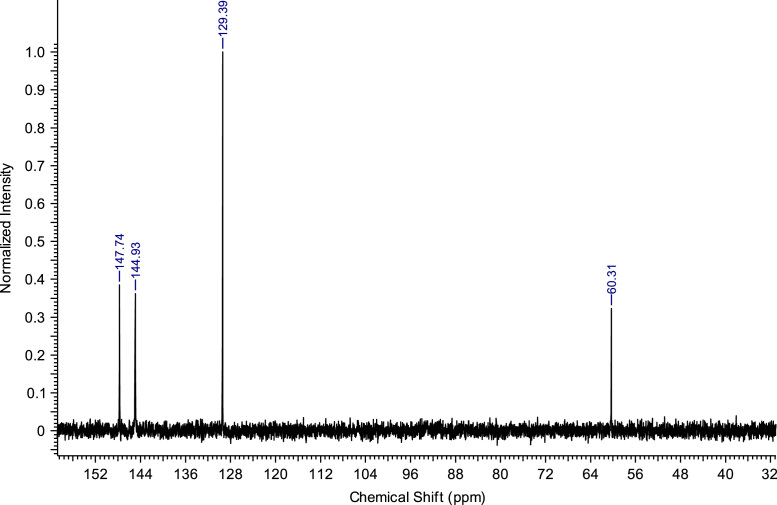
13C NMR spectra of C2(Pyr)2Br2.